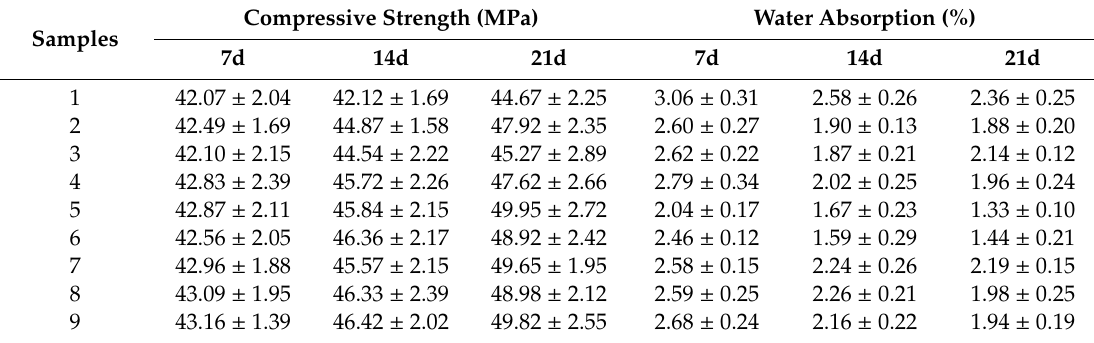
Table 3. Experimental results of the compressive strength and water absorption of mortar.